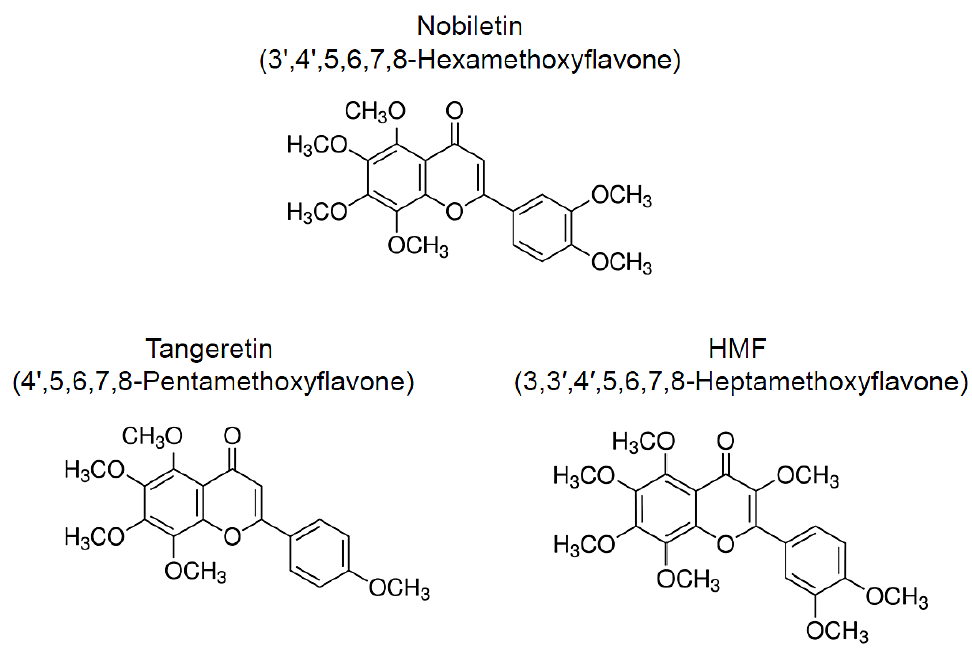
Figure 1. Chemical structure of citrus-derived polymethoxylated flavones, nobiletin, tangeretin, and 3,3 ′ ,4 ′ ,5,6,7,8-heptamethoxyflavone (HMF).